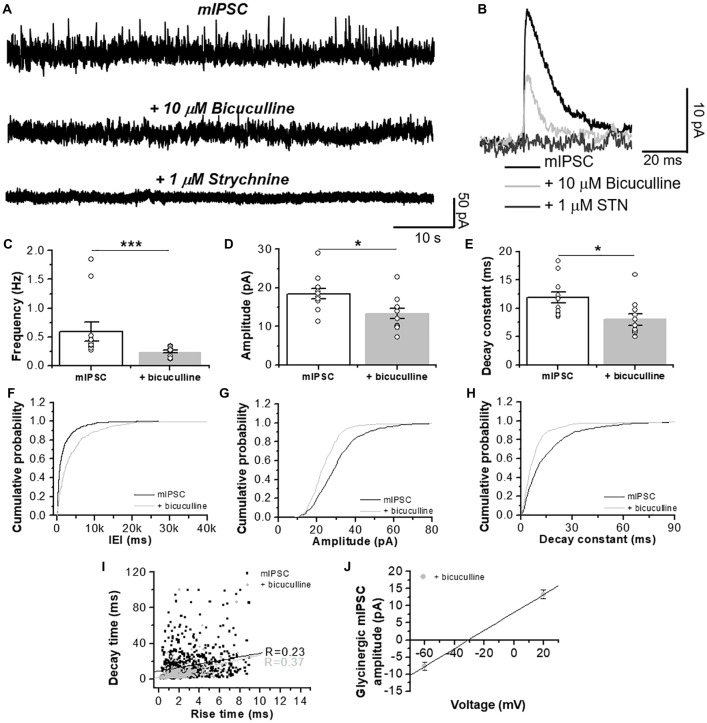
GlyR-mediated chloride currents in D1 MSNs are inhibited by STN. (A) Representative synaptic traces in presence of CNQX (10 μM) and D-APV (50 μM), plus bicuculline (10 μM) and STN (1 μM) recorded at a +20 mV holding potential in neurons from D1-GFP mice. (B) Average traces of total pharmacologically isolated mIPSC (black line), mIPSC plus 10 μM bicuculline (light gray) and plus 1 μM STN (dark gray). (C–E) Graphs summarize the chloride current properties in D1 MSNs showing a decrease in frequency (p = 0.001, t20 = 2.109, Unpaired Student’s t-test, Mann-Whitney test), amplitude (p = 0.013, t20 = 2.711 Unpaired Student’s t-test) and decay constant (p = 0.011, t20 = 2.8 Unpaired Student’s t-test). Those currents were sensitive to 1 μM STN. (F–H) The graphs are cumulative histograms of frequency, amplitude and decay time (10%–90%) in D1 MSNs. (I) The graph shows lack of relationship between rise time constant (10%–90%) vs. decay time constant (10%–90%) of chloride synaptic events for GABA (R = 0.23) and glycine mIPSCs (R = 0.37). (J) The graph shows the relationship between voltage holding (−60 and +20 mV) and the amplitude of the GlyR-mediated mIPSCs. Using the chord conductance equation we calculated that the reversal potential of glycinergic mIPSC was −31 mV. The data are mean ± SEM. (n = 11). ns p < 0.05, *p < 0.05, ***p < 0.001.